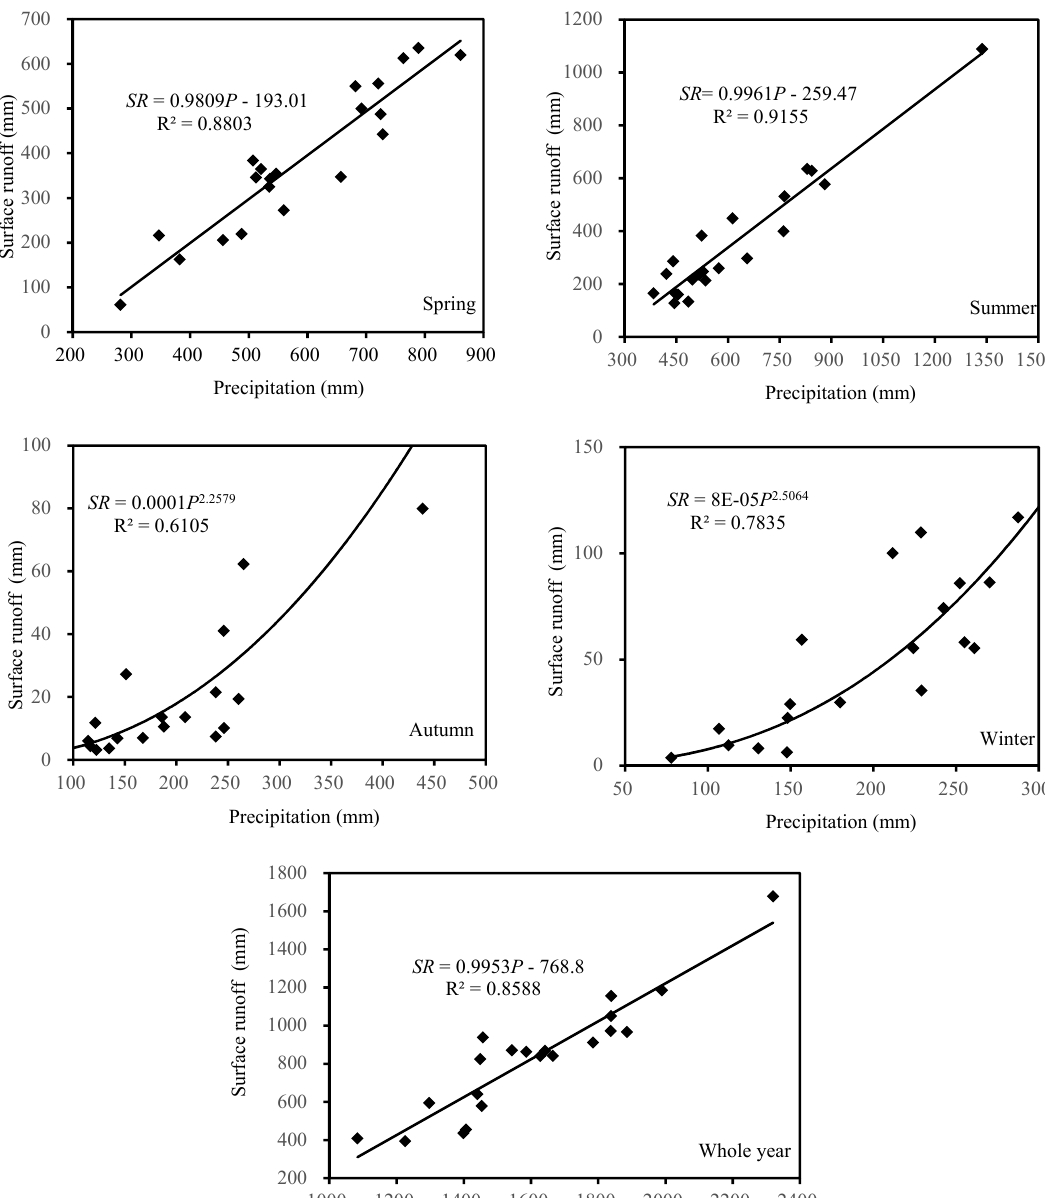
Figure 9. Relationship between observed surface runoff and precipitation in seasonal and annual scale during baseline period.